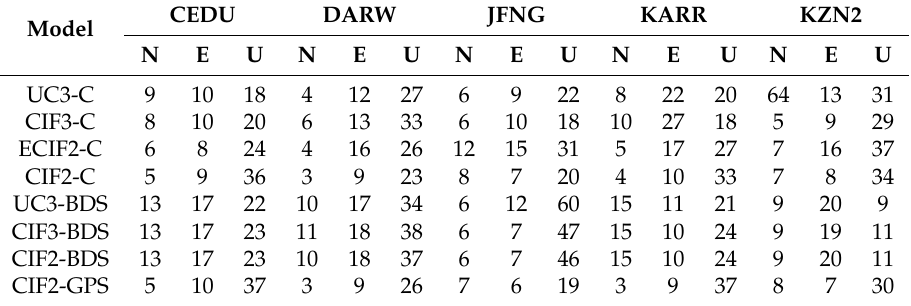
Table 6. Precisions for different combined models with the daily solution in North, East, Up directions (mm). Model